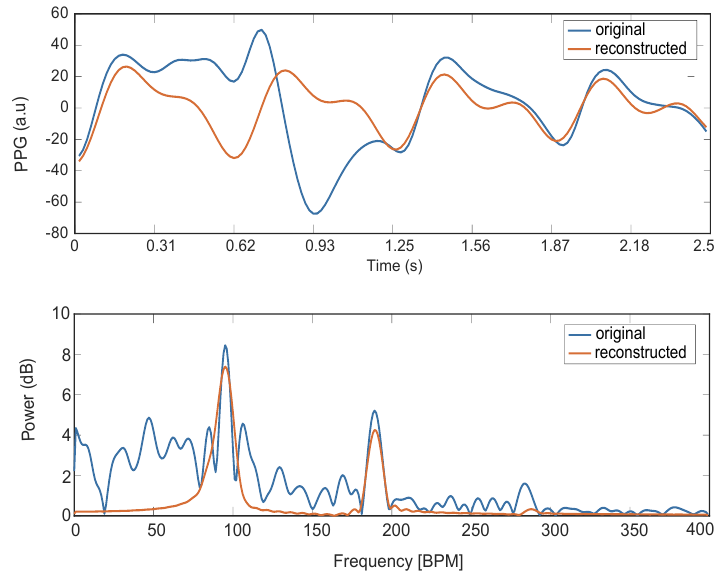
Figure 6. Example of noisy PPG signal and its spectrum. Both original and reconstructed are